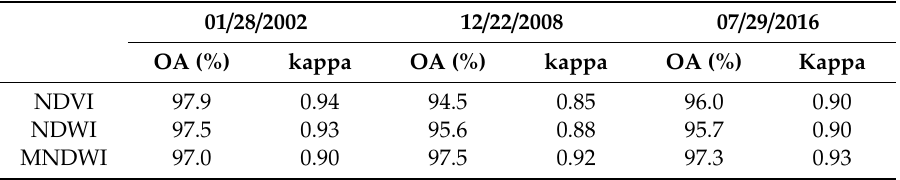
Table 5. Overall accuracy and kappa coe ffi cient of the spectral indices in three test